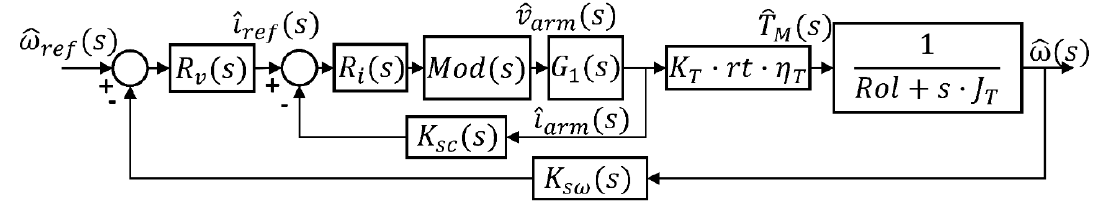
Figure 10. Simplified block diagram with inner and outer loops.